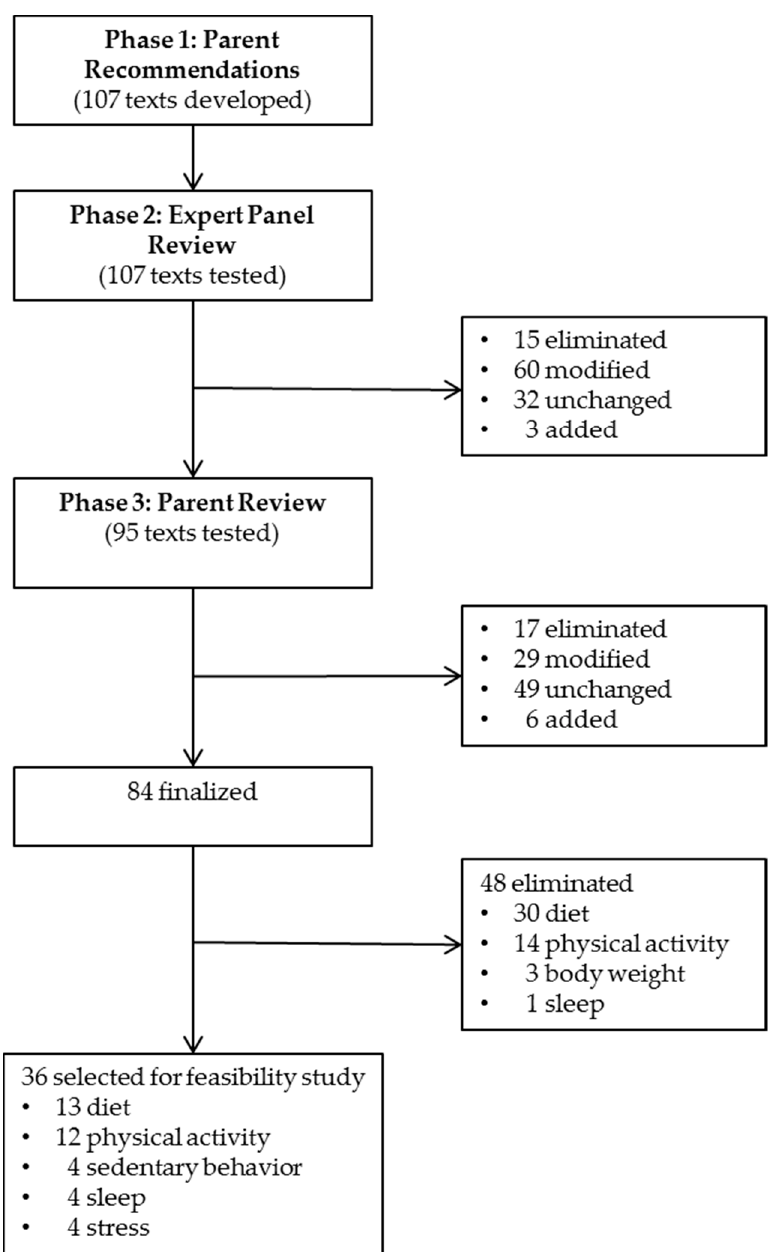
Figure 1. Text Message Development Phases 1–3.